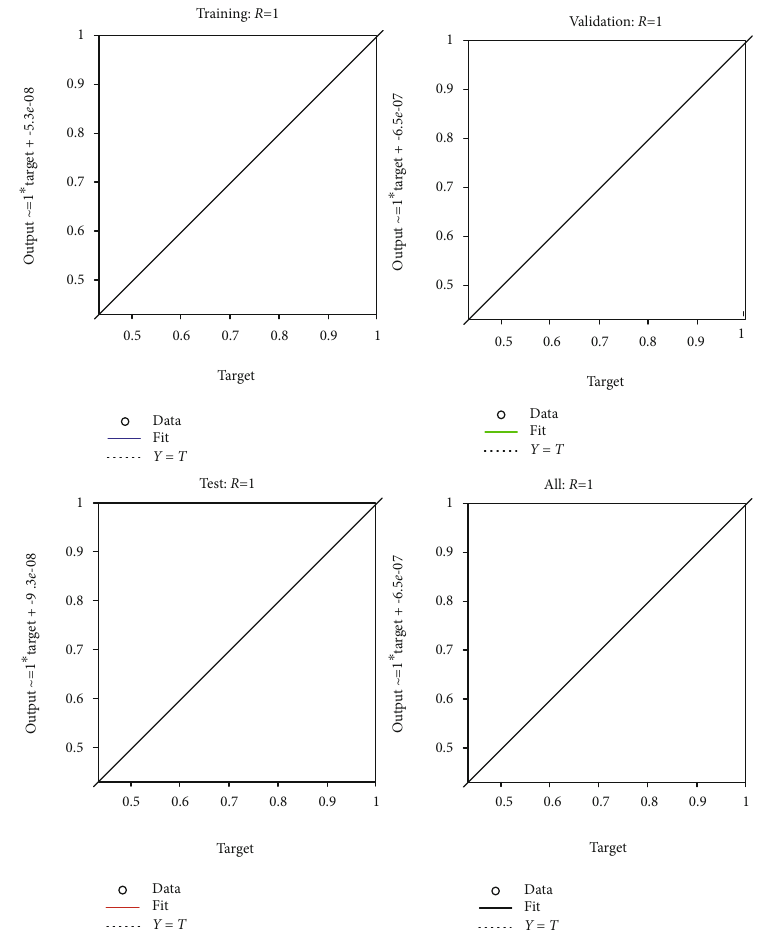
Figure 17: Training and validation of the DNN-based fuel fl ow controller.